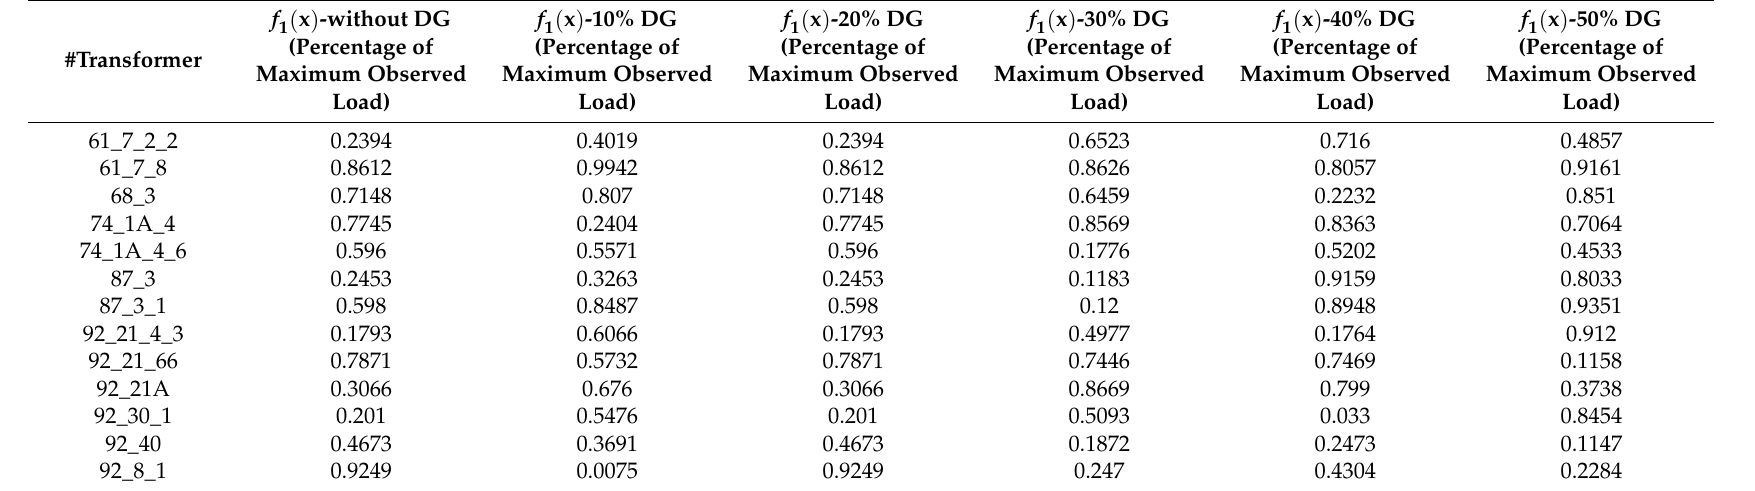
Table 2. Optimal loading per node according to f 1 ( x ) , for increasing production from to 50% to full of the distributed generator’s installed capacity.